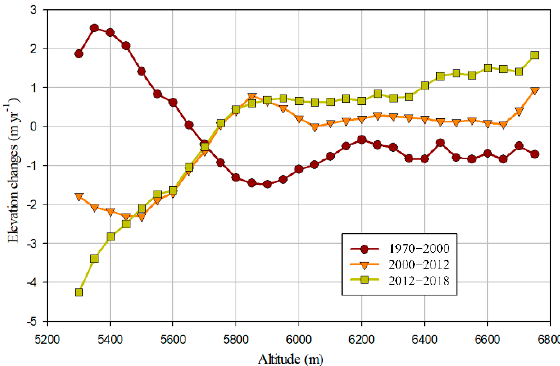
Figure 9. Glacier surface elevation changes versus altitude over the Chongce Glacier during the periods of 1970–2000, 2000–2012, and 2012–2018.